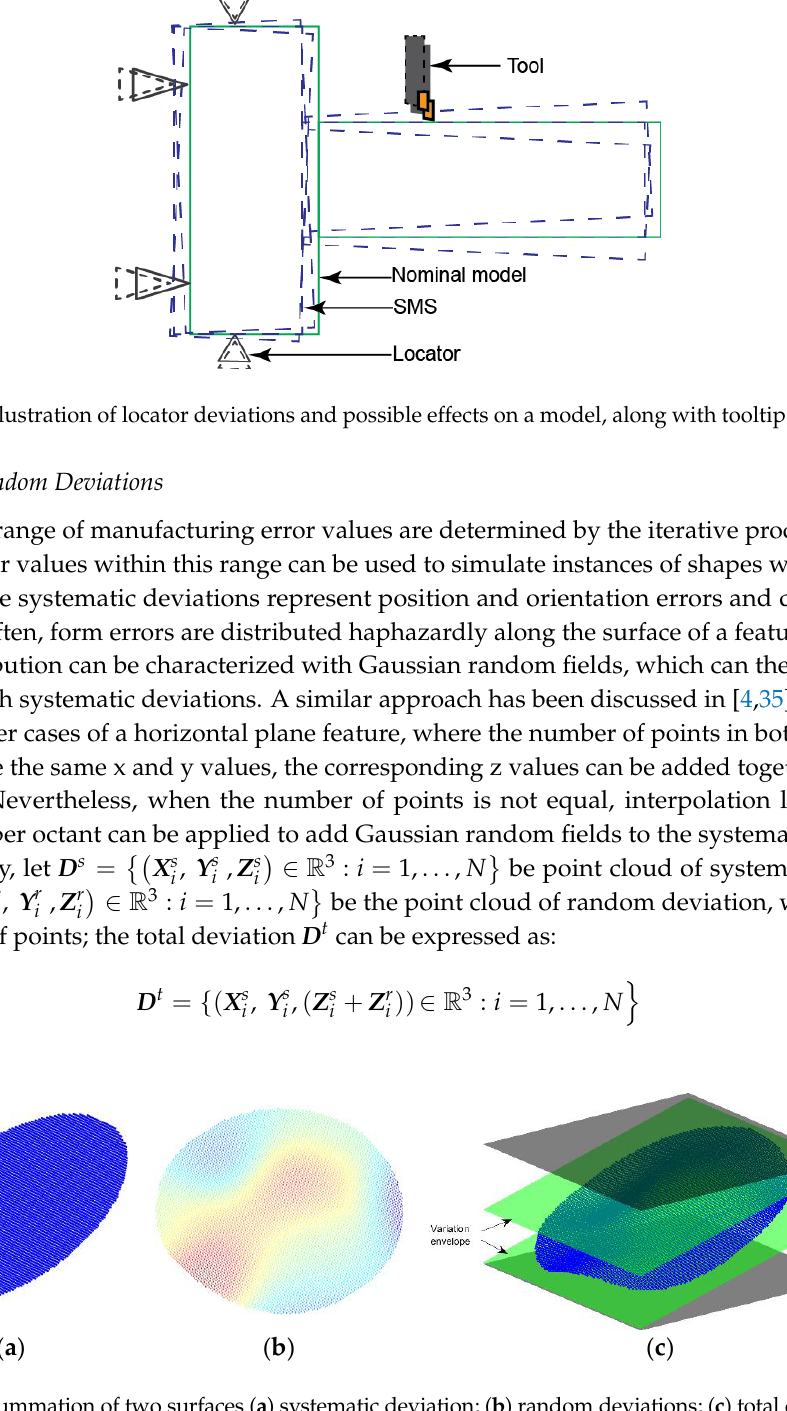
Figure 8. Summation of two surfaces ( a ) systematic deviation; ( b ) random deviations; ( c ) total deviations.